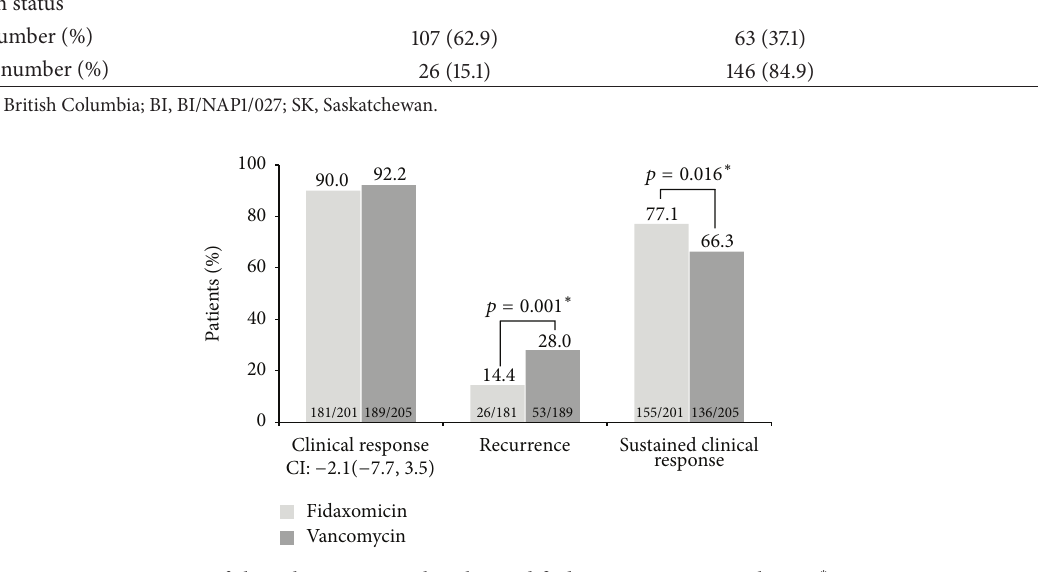
Figure 2: Rates of clinical outcomes within the modified intent-to-treat population. ∗ 𝑝 < 0.05